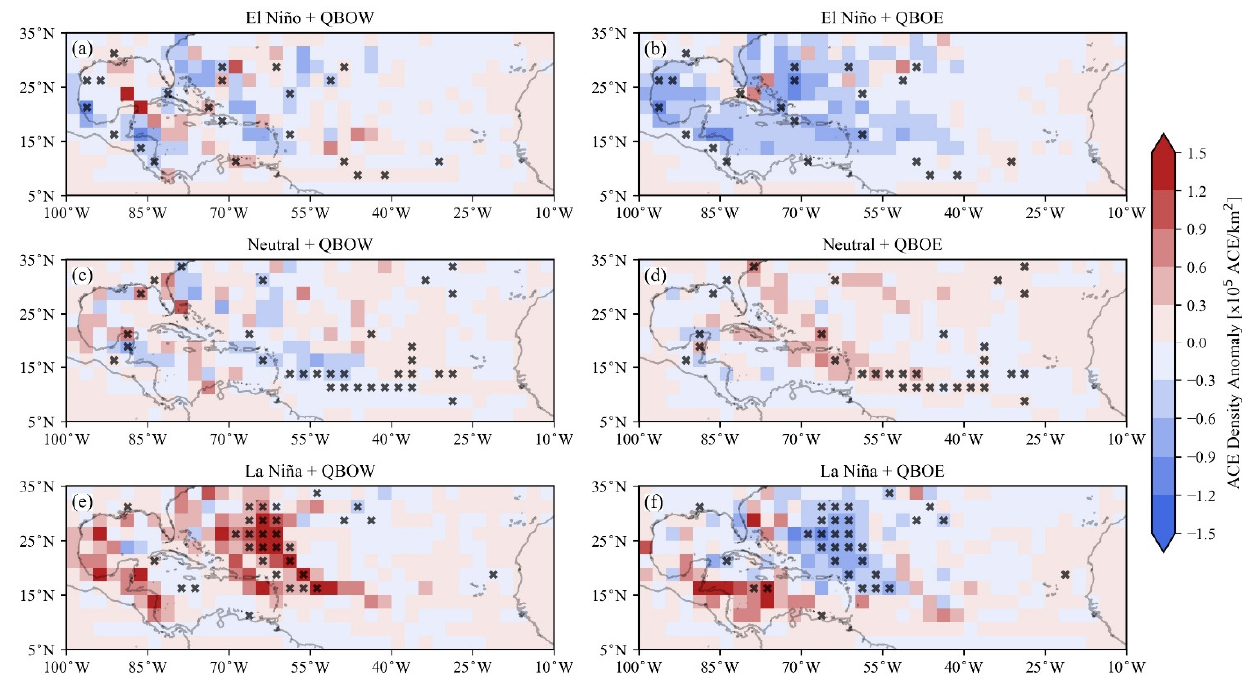
Figure 4. ( a ) El Niño + QBOW, ( b ) El Niño + QBOE, ( c ) Neutral + QBOW, ( d ) Neutral + QBOE, ( e ) La Niña + QBOW, and ( f ) La Niña + QBOE. Same as Figure 3, but for the Mean ACE density anomalies during the season JJASON for the years classified as ENSO and QBO phases during the 1953–2020 period. The crosses show the statistically significant regions where the p -value of the Mann-Whitney U test is lower than 0.1.